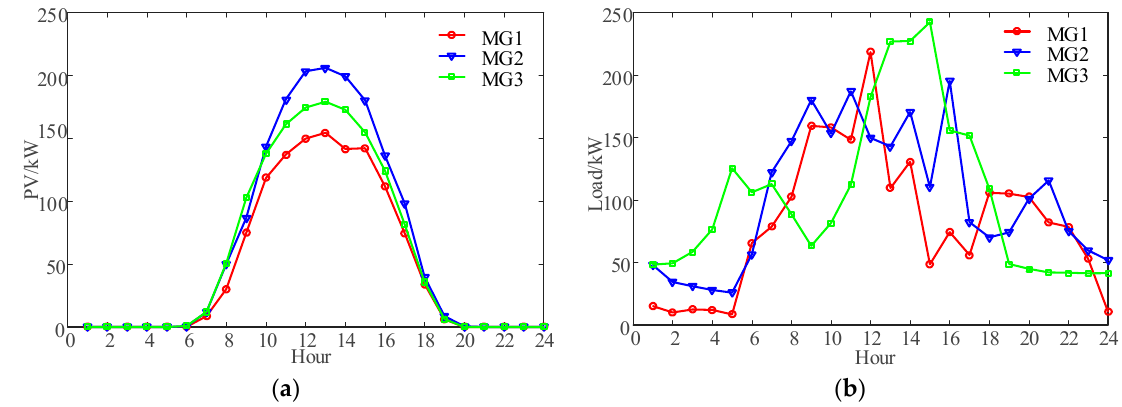
Figure 4. Basic data in hour: ( a ) PV energy output for 3 MGs, and ( b ) load demands for 3 MGs.